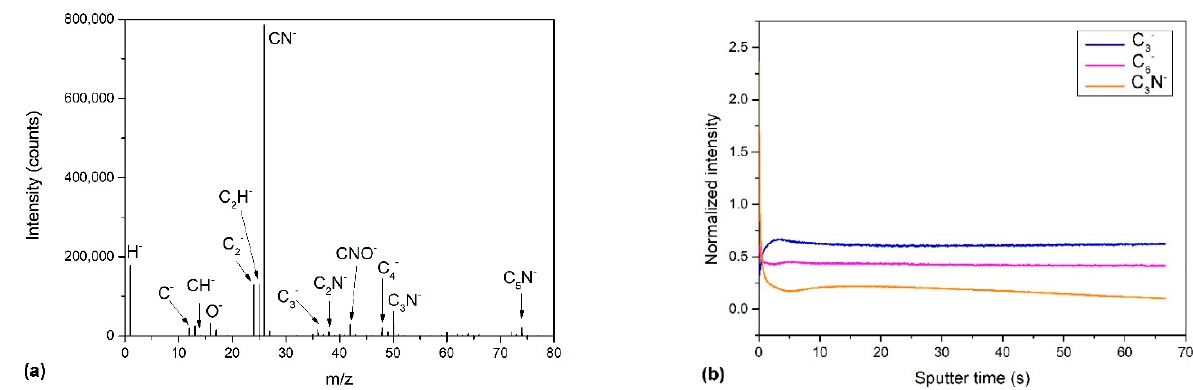
Figure 11. ( a ) Secondary ion mass spectrometry (SIMS) negative ion spectrum of the N-doped carbon nanomesh sample (deposition time 60 s) and ( b ) SIMS depth profile of this sample.